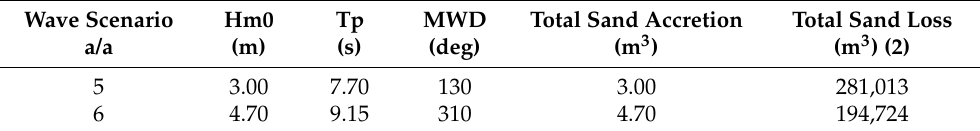
Table 5. Comparison of tombolo destructive wave scenario results of total volume of sand erosion in the active area for salient